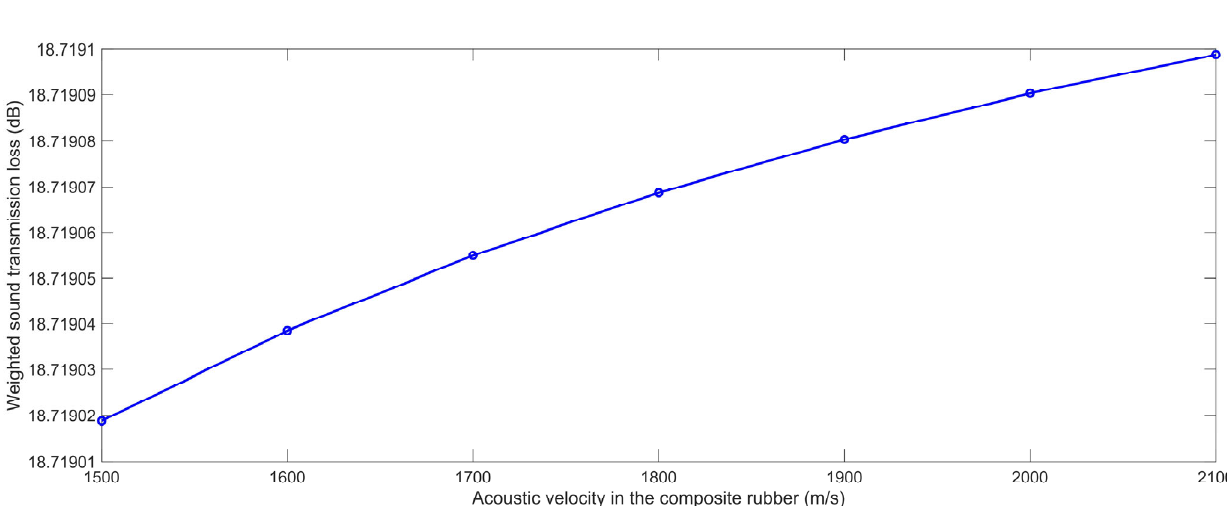
Figure 16. The weighted STL of composite rubber reinforced with HGM for the various acoustic velocity in the composite